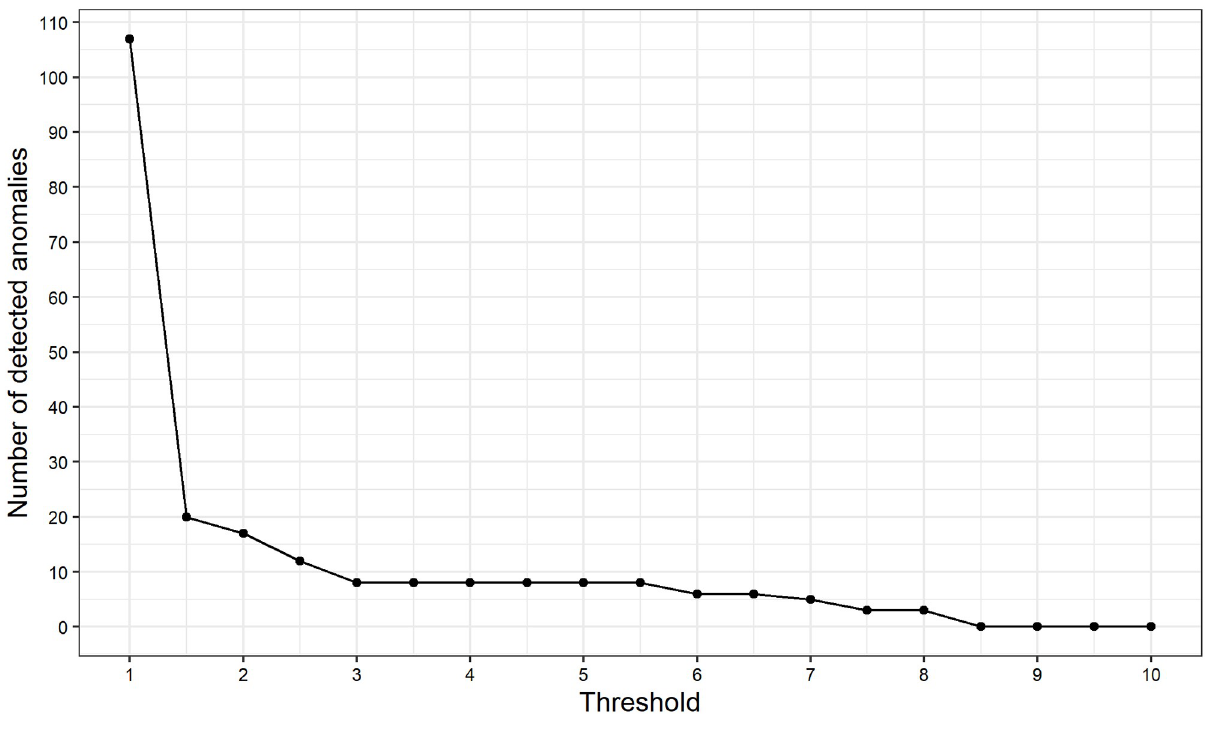
Fig 13. Number of detected anomalies by threshold r